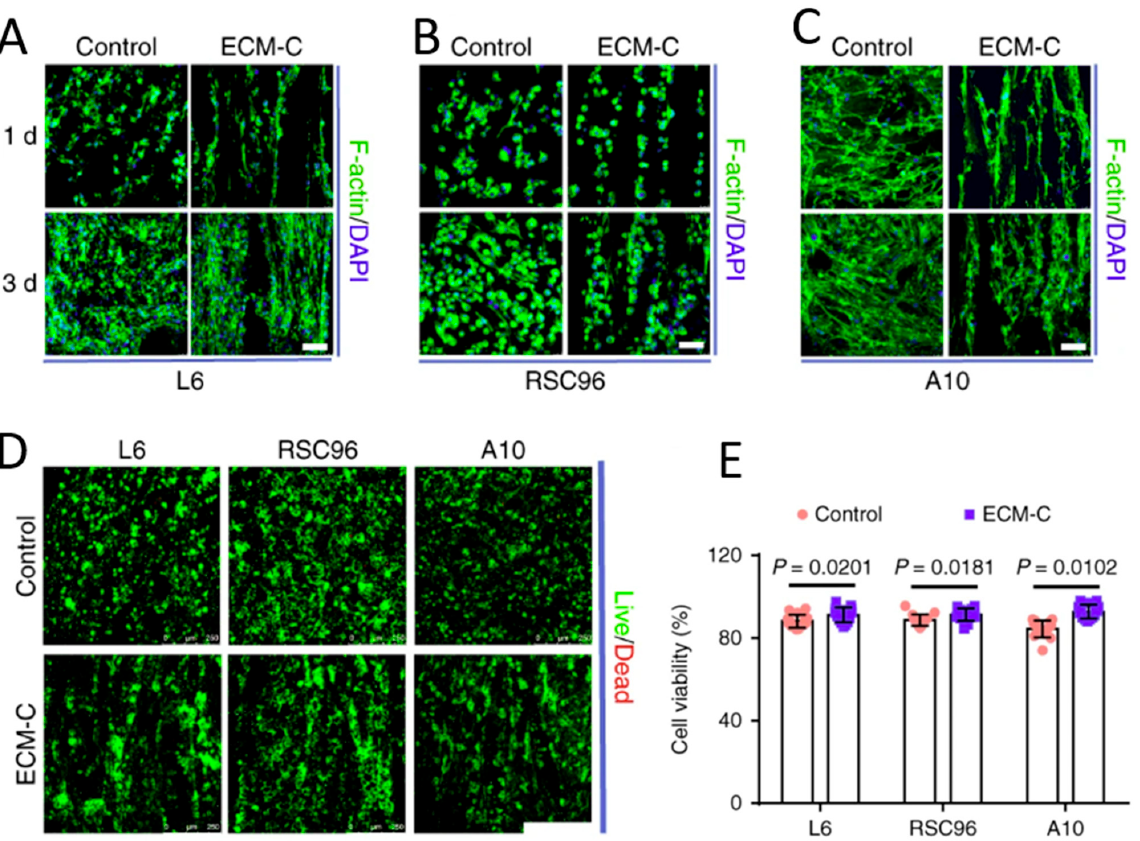
Figure 1. Materials composed of cells and ECM show promise for recreating the complex, hierar- chical structure of functional skeletal muscle tissue. ECM–cell composite scaffolds effectively guide cells towards the spatial organization required for muscle, nerve, and blood vessel formation. ( A – C ). Cellular guiding effects of ECM–cellular (ECM–C) and control scaffolds. Skeletal actin fibers and nuclei of ( A ) L6, ( B ) RSC96, and ( C ) A10 cells were respectively stained with fluorescein isothiocyanate (FITC) conjugated phalloidin and DAPI at one and three days. ( D , E ) Live/dead staining and cell viability of L6, RSC96, and A10 cells on different scaffolds at seven days. Live cells are stained green and dead cells are stained red ( n = 15). Figure adapted with permission from Zhu et al. 2019 [33].